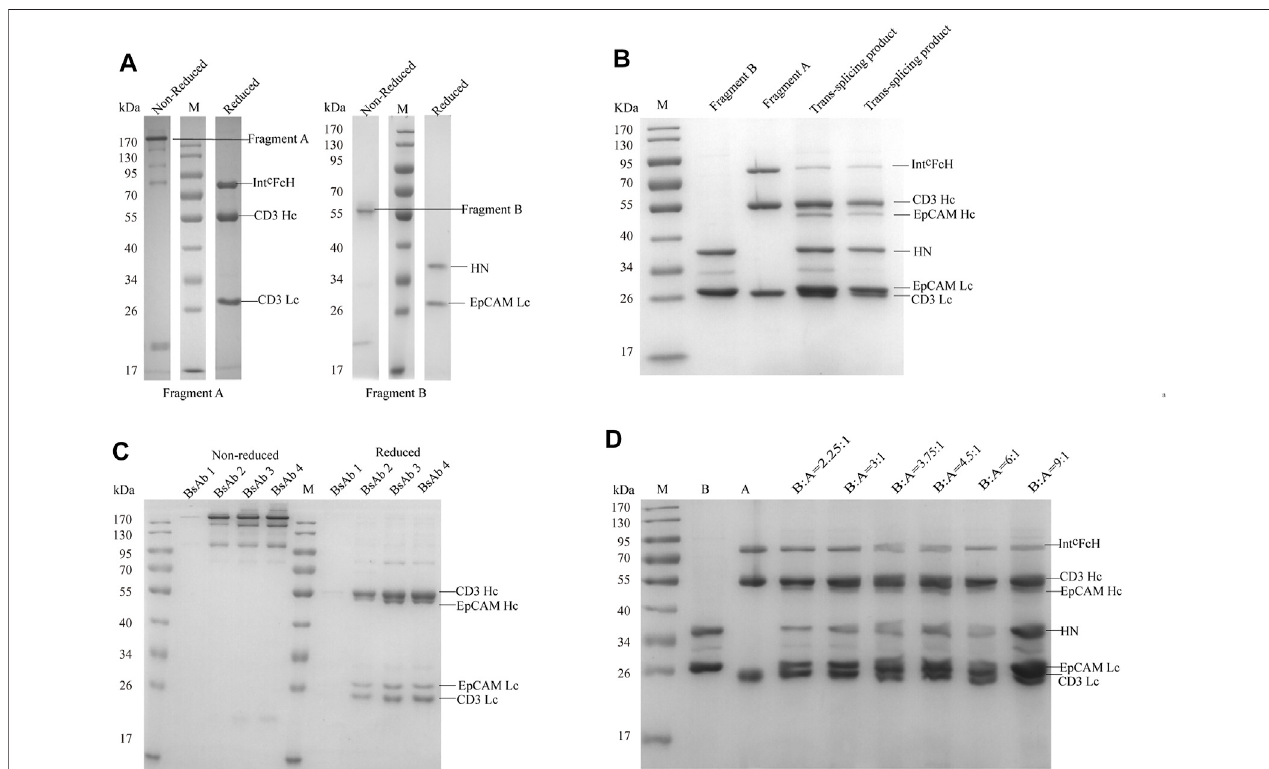
FIGURE 2 | SDS-PAGE analysis of CD3×EpCAM bispeci fi c antibody. (A) SDS-PAGE analysis of CD3×EpCAM bispeci fi c antibody CD3 fragment A and EpCAM fragment B under non-reduced and reduced conditions. (B) Trans -splicing reaction between CD3 fragment A and EpCAM fragment B at 37 ° C with 1.5 mM DTT for 2 h (C) CD3×EpCAM BsAb under non-reduced and reduced conditions. (D) Trans -splicing reaction condition optimization between the different fragments A and B ratios with 1.5 mM